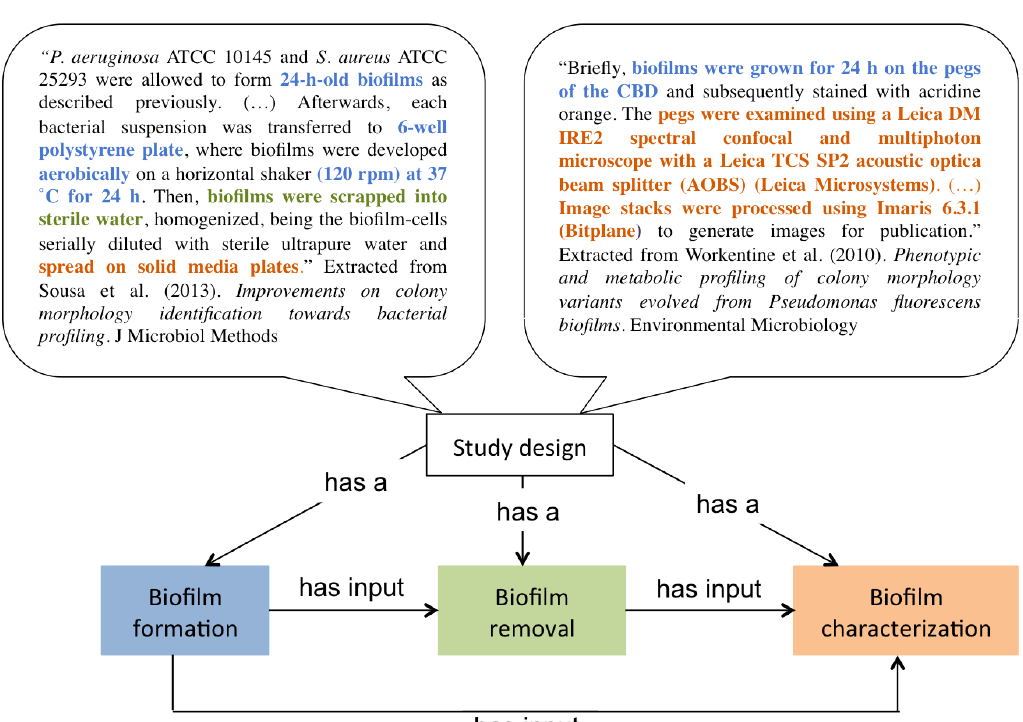
Figure 4: Information model for semantic annotation of biofilm studies using the new Biofilms